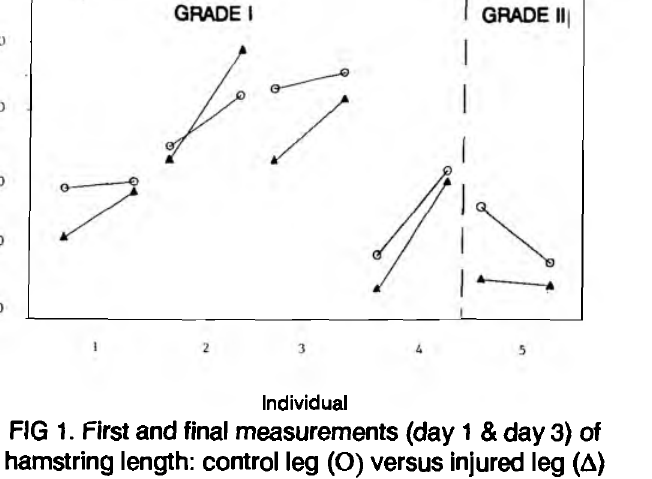
FIG 1. First and final measurements (day 1 & day 3) of hamstring length: control leg (O) versus injured leg (A) injured and control leg of the different individuals are shown in figure 1. Figure 2 represents the changes in hamstring length of the injured leg, in degrees, before and after treatment over the three days.